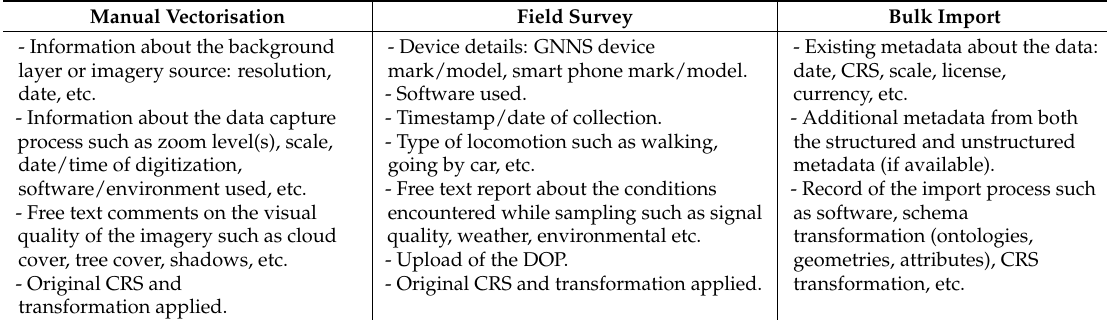
Table 2. Suited metadata in relation to the data collection